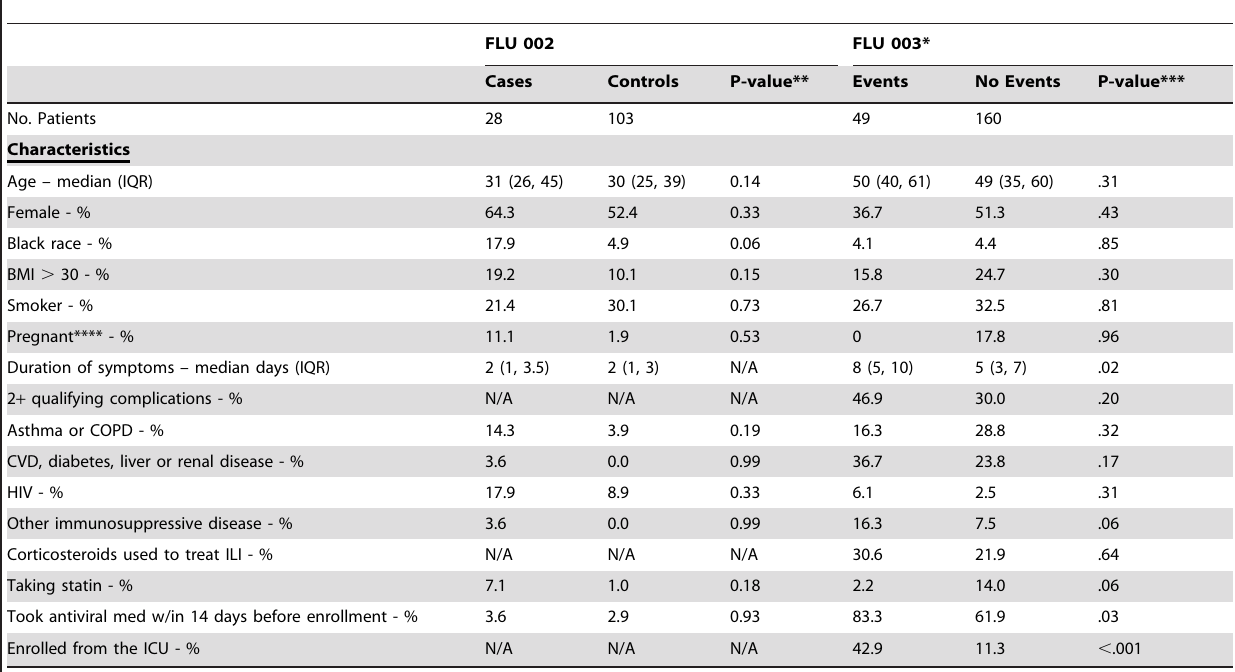
Table 3. Baseline Characteristics of Patients in the FLU 002 and FLU 003 Biomarker Cohorts According to Event